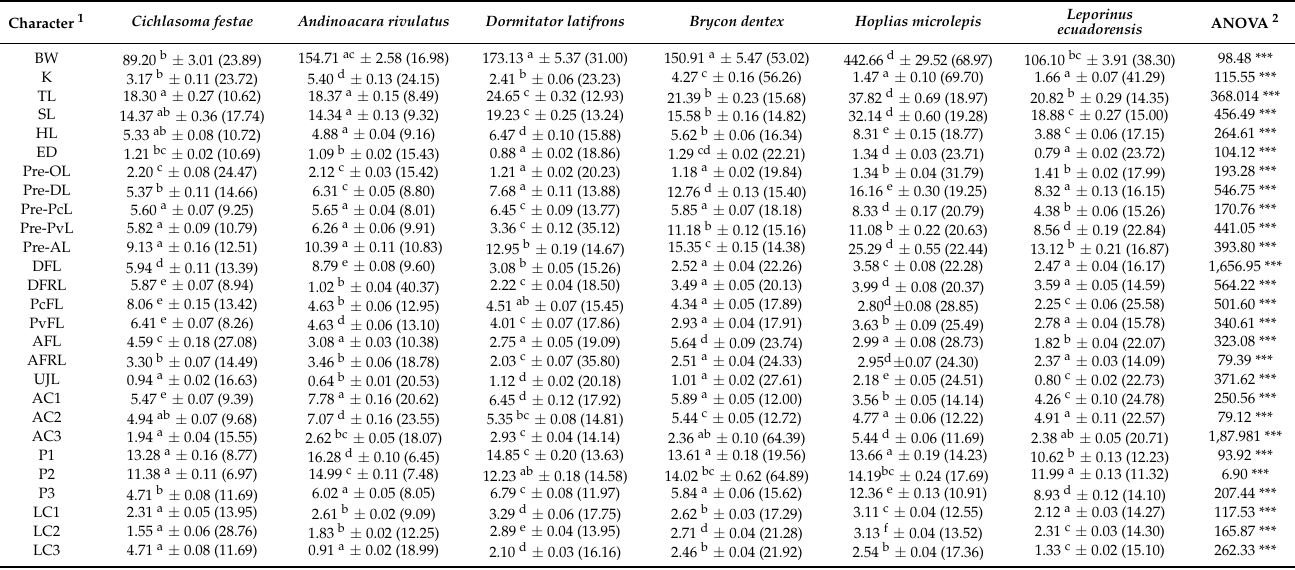
Table 2. Descriptive statistics of body measurements (original data) of six freshwater species from Ecuador (Mean ± Standard Error (Coefficient of